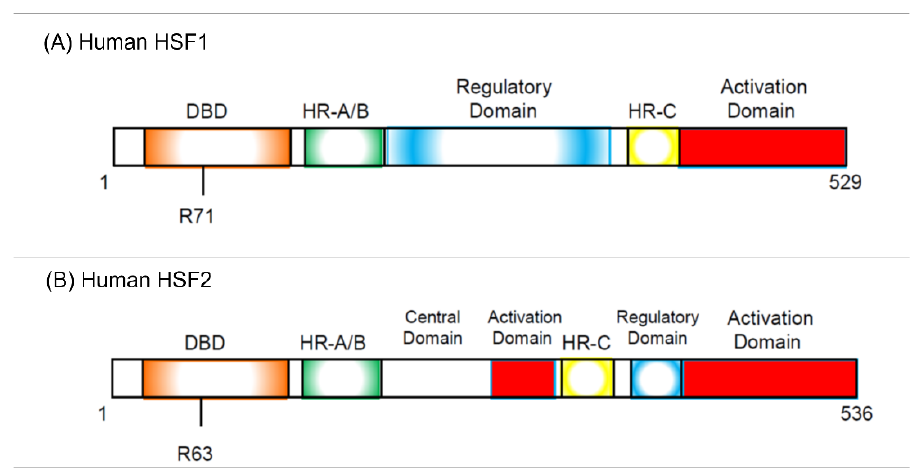
Figure 1. Structure of human HSF1 (hHSF1, ( A )) and human HSF2 (hHSF2, ( B )). hHSF1 and hHSF2 have similar domain structures, but several differences exist. R71 and R63 are required for DNA binding in hHSF1 and hHSF2, respectively. The regulatory domain suppresses trimerization of both HSFs and inhibits transcriptional activation. Trimerization is required for the activation of HSFs. DBD, DNA-binding domain; HR-A/B, hydrophobic heptad repeats A and B; HR-C, C-terminal hydrophobic heptad repeat.